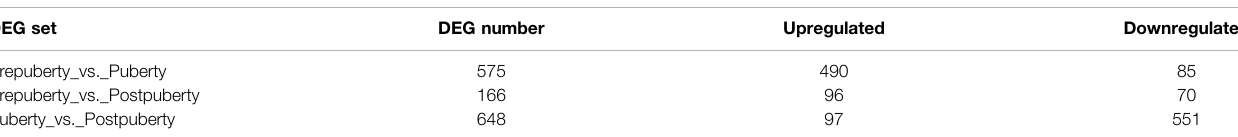
TABLE 2 | The number distribution of differentially expressed genes in different sample